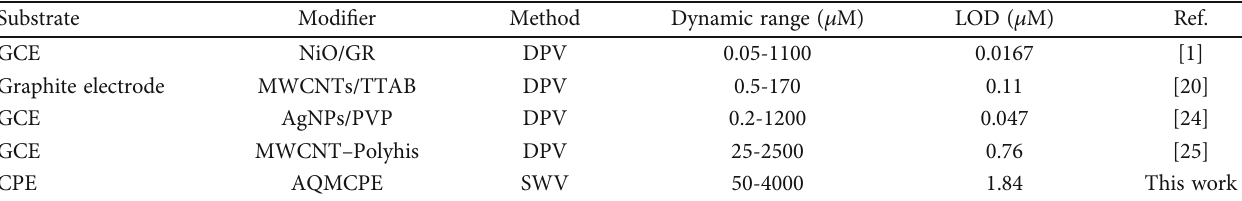
Table 4: Comparison of performance of the present method with selected recently reported works in terms of the linear dynamic range, LOD, electrode substrate, and modi fi